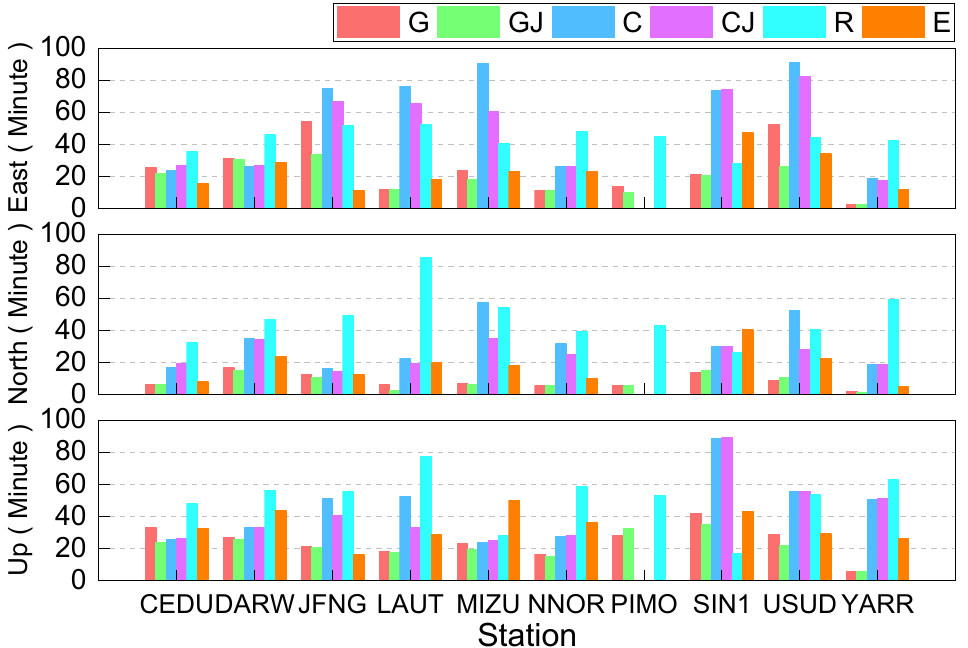
Figure 11. Mean convergence time for kinematic PPP in each station.